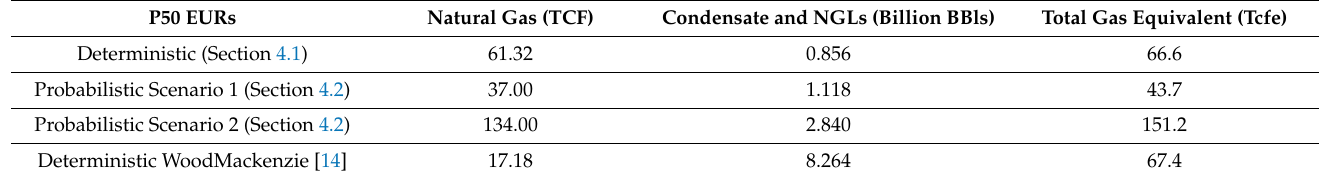
Table 10. P50 EUR estimations for Jafurah field development